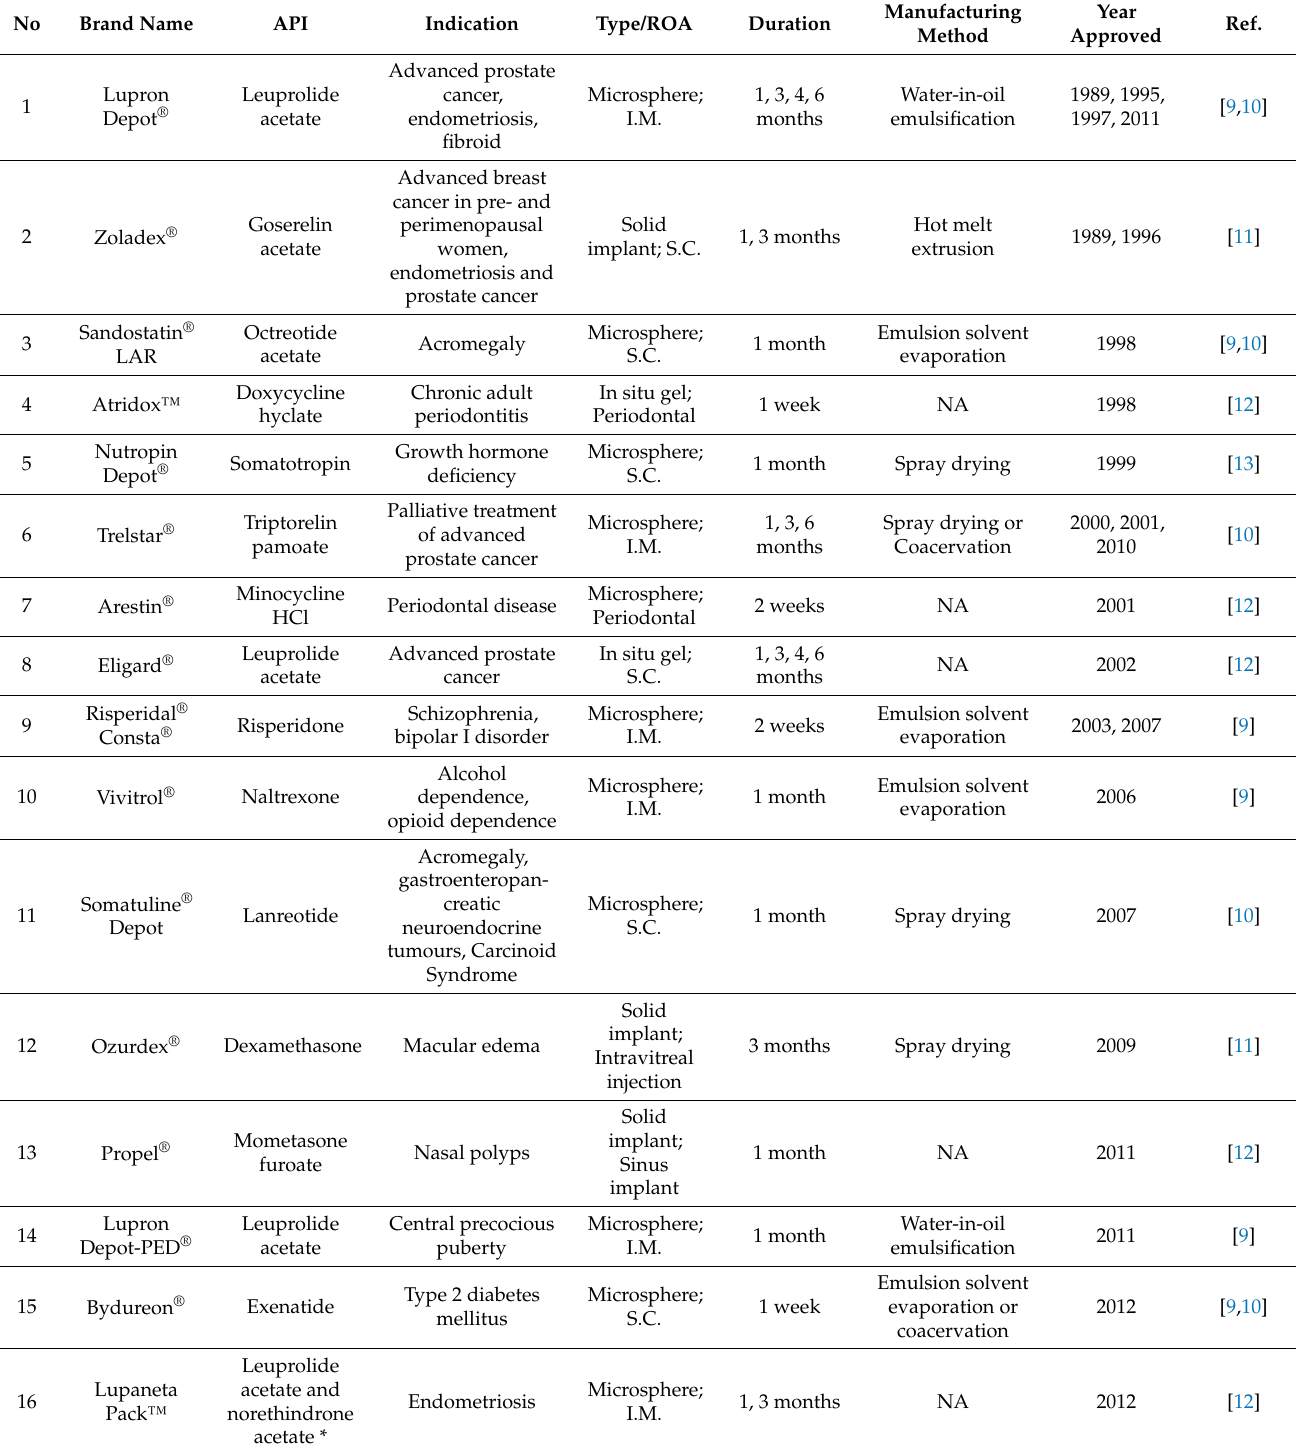
Table 1. PLGA-based long-acting drug products approved by FDA †